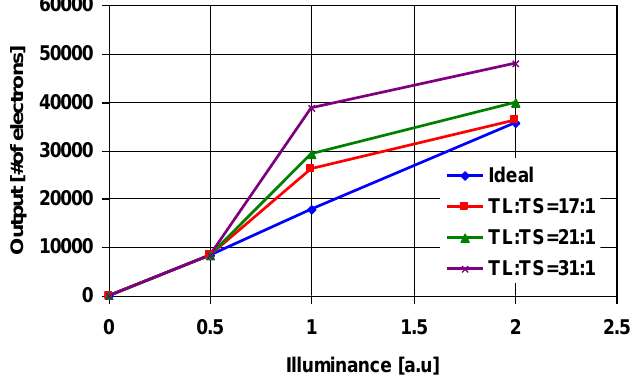
Figure 10. Photo-electric conversion characteristics of the synthesized wide dynamic range signals.